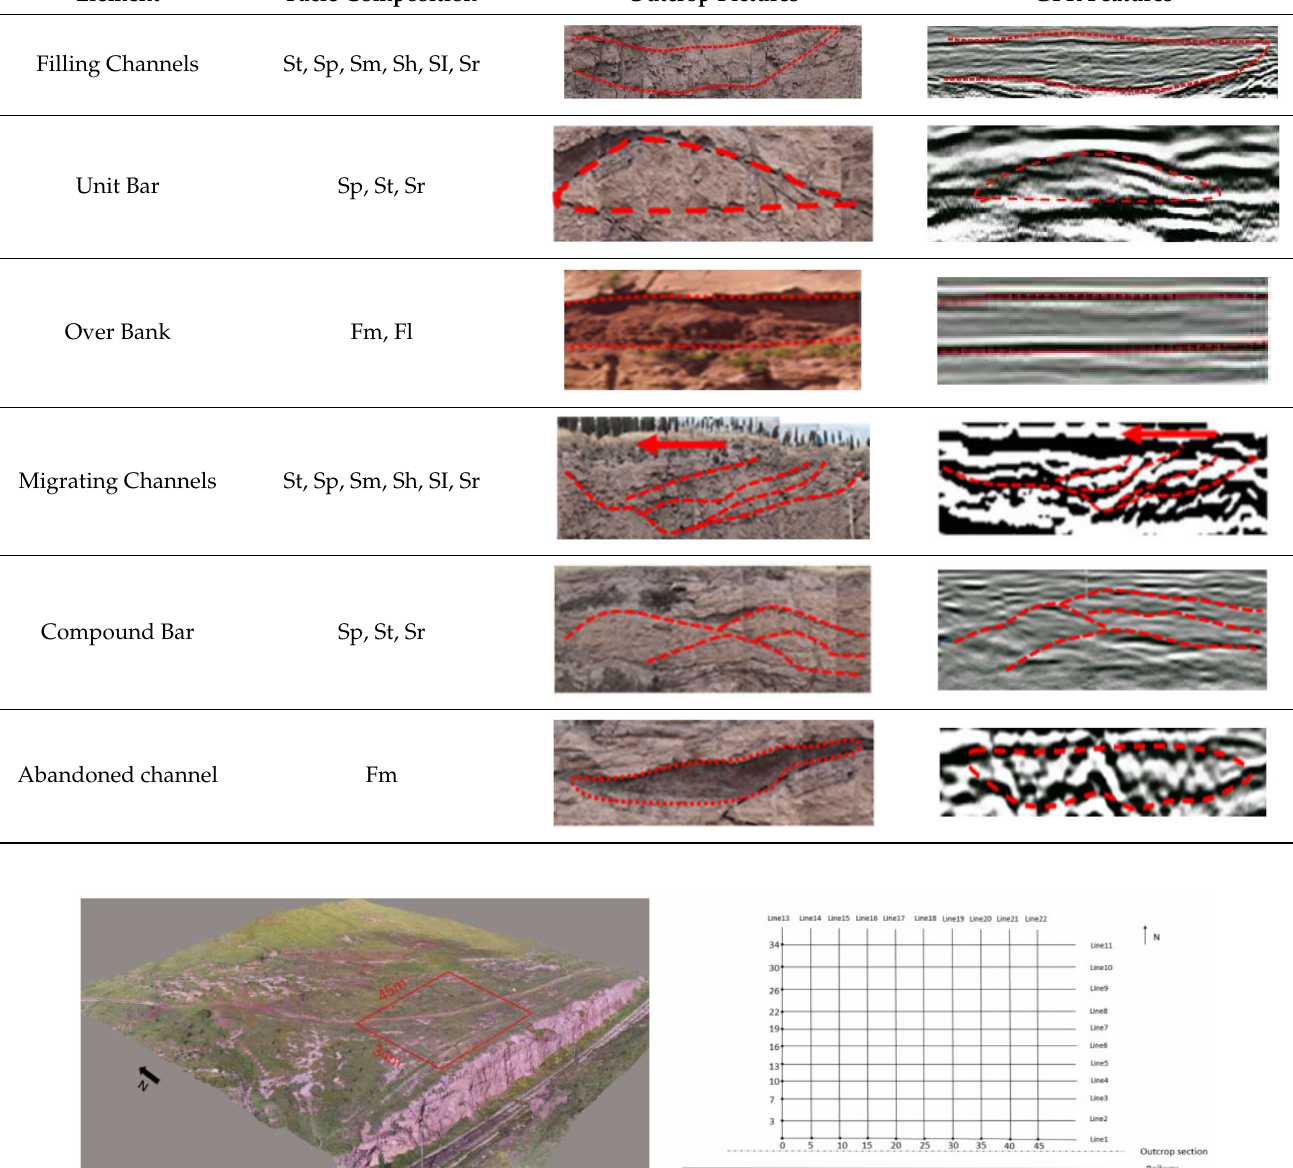
Figure 9. The 3D GPR survey grid of Outcrop No. 4. The size is 45 × 34 m, and the track pitch is 5 m in the X direction and 3.4 m in the Y